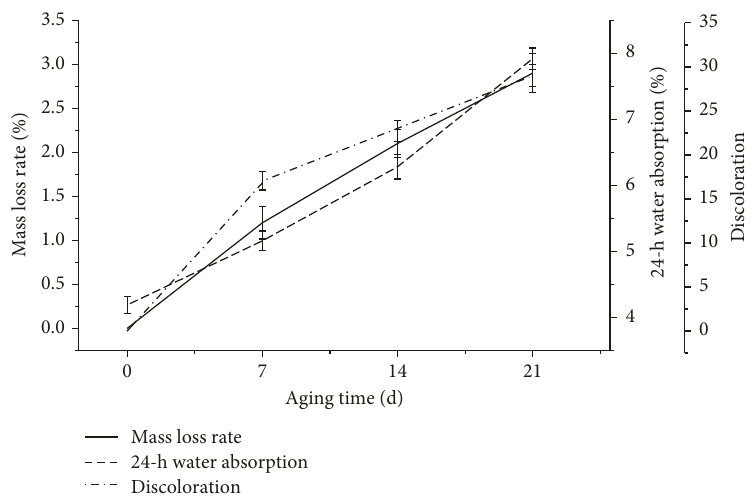
Figure 1: Mass loss rate, 24 h water absorption, and discoloration of the composites.